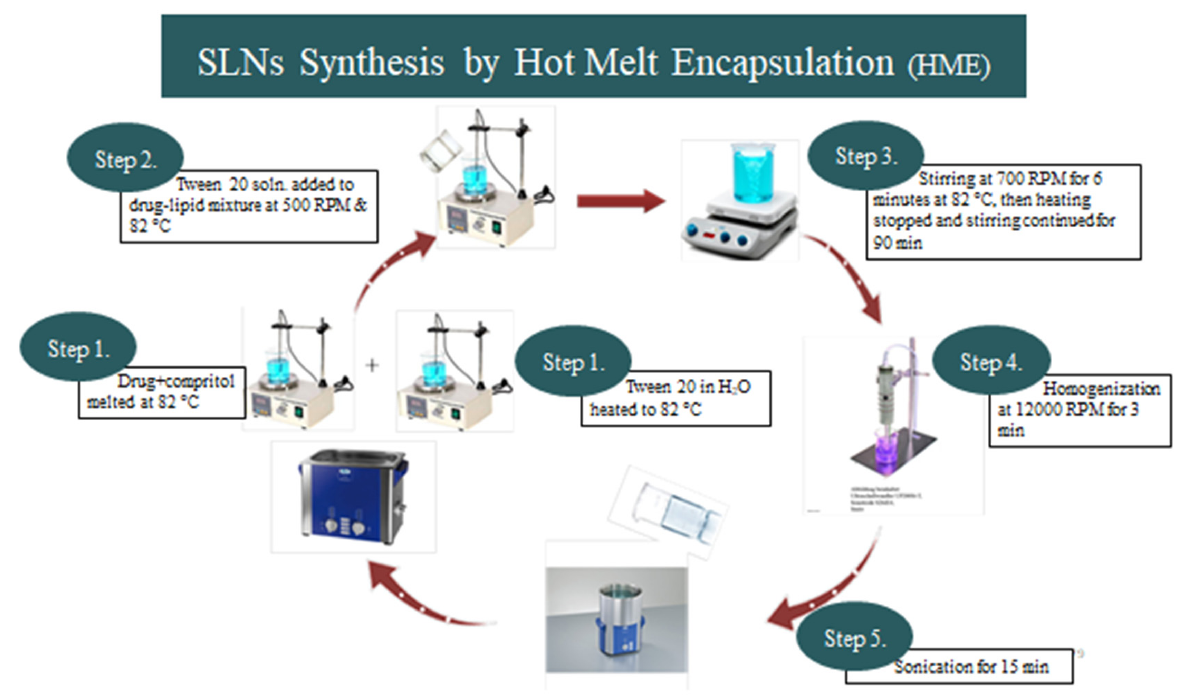
Figure 9. HME technique for preparation of compritol based alprazolam SLNs.